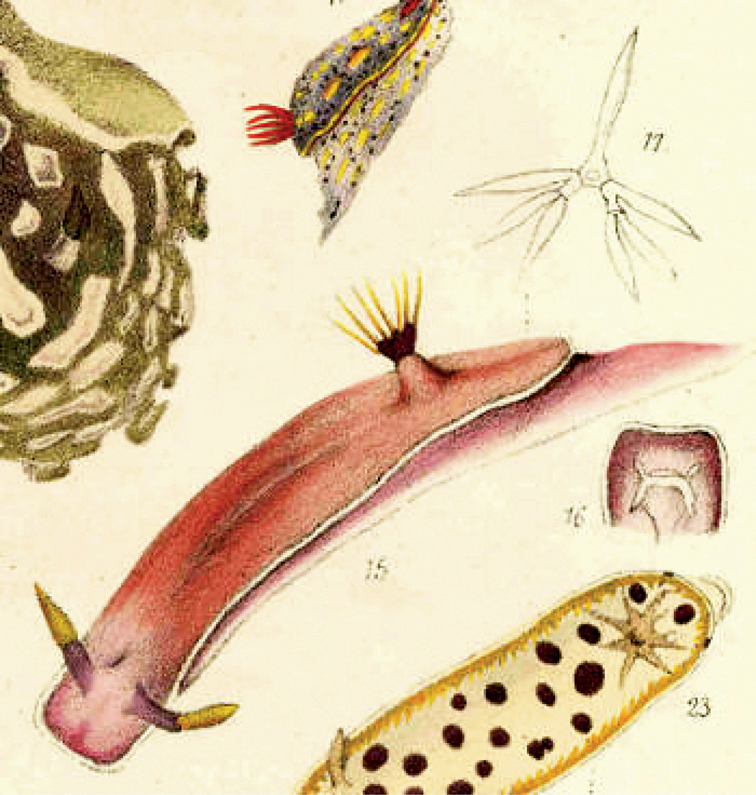
Chromodoris bullockii Collingwood, 1881: figs 15, 16, 17.